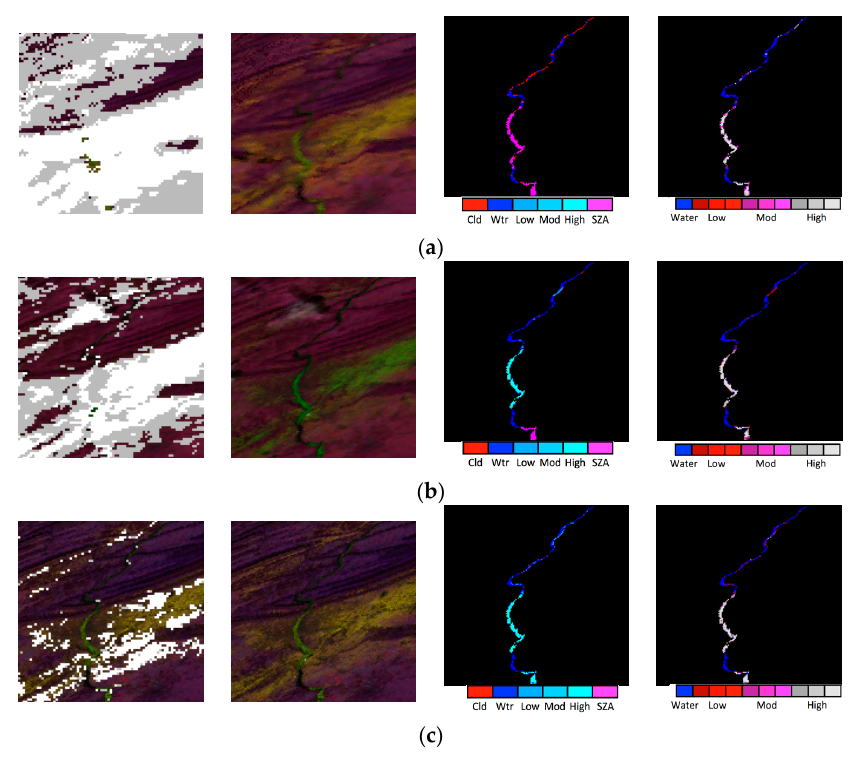
Figure 4. MODIS-Terra ( a ); MODIS-Aqua ( b ); and VIIRS ( c ) data and results of STC processing for 9 January 2014. False color images were produced by mapping the following bands as red, green and blue: 2 (visual inspection showed that MODIS-Terra band 5 had a minor artifact consisting of narrow, slanted bands of alternating brightness), 4, 7 for MODIS-Terra; 5, 4, 7 for MODIS-Aqua; I2, I1, I3 for VIIRS. The leftmost panels show an overlay of the cloud products for “confidently cloudy” (white) and “mixed” (gray). The second image shows the region of interest in a false color display, with yellow/green color corresponding to snow and ice, magenta colors corresponding to land and greyscale corresponding to optically thick clouds. The third image shows the classified image on water grids, indicating clouds and ice (three confidence levels) and ice viewed at large view angle (SZA > 40°). The rightmost image shows the composited ice cover (at cloud covered grids, the result of most recent classification is used) according to confidence and reflectance magnitude. A collection of ice corresponding to an ice jam is visible in the center of the field of view. The leftmost column shows an overlay of NASA cloud processing results on top of false color imagery. MODIS data are cloudier than VIIRS data. The second column from the left provides the false color imagery, showing that river (black), ice (yellow-green), snow (yellow-green) and land (magenta) can be reasonably well identified by visual inspection. The third column is the main product from which the time series and cloud statistics are developed, and shows the result of STC processing: ice vs. cloud confidence in three levels (“Low”, “Mod”, and “High”), a warning flag for large sensor zenith angle (SZA, >40°, only marked at “ice” grids), water and clouds. Terra data were obtained at poor SZA, and as result STC classified some river grids as clouds in the upper portion of the river. The fourth column shows the running composite. It is only shown here to more clearly indicate the ice/cloud confidence levels, which are further subset according to reflectance magnitude, since the running composite maps do not overlay information on clouds or SZA. The figure shows the cloud-clearing ability of STC vs. NASA processing. All classified ice maps are in good agreement with visual inspection. Ice/water delineations are nearly identical. Ice is classified with similar confidence between the platforms.